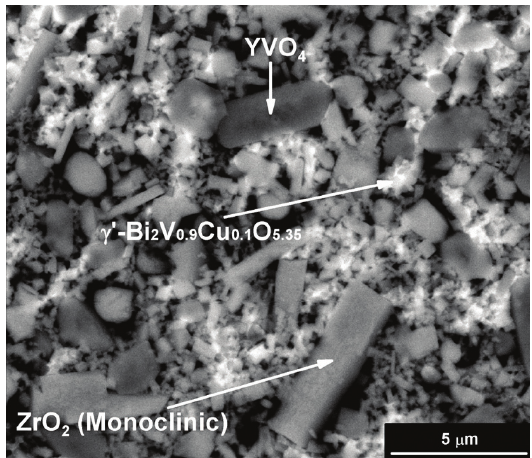
Figure 2. Backscattered electron micrograph of the sample 50B/50Z3. Phases and products derived from reactions between BICUVOX.10 and 3Y-TZP are indicated by